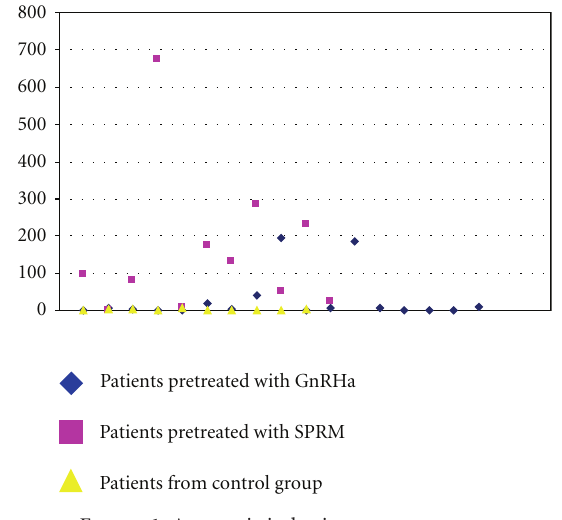
Figure 1: Apoptotic index in separate